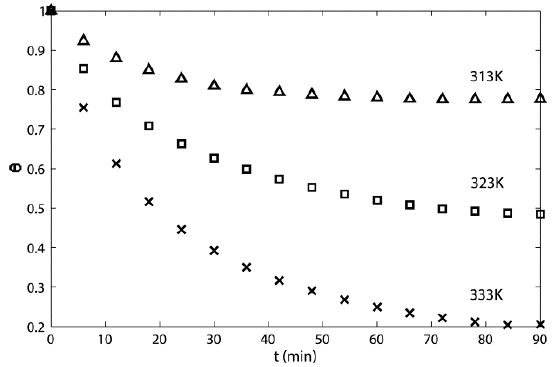
Figure 6. Toluene thermal desorption curves of silica gel.